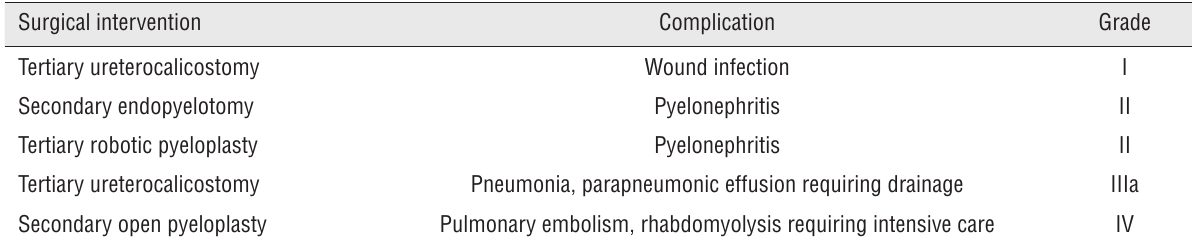
Supplementary Table S2 - Surgical complications following salvage intervention for ureteropelvic junction obstruction. Surgical